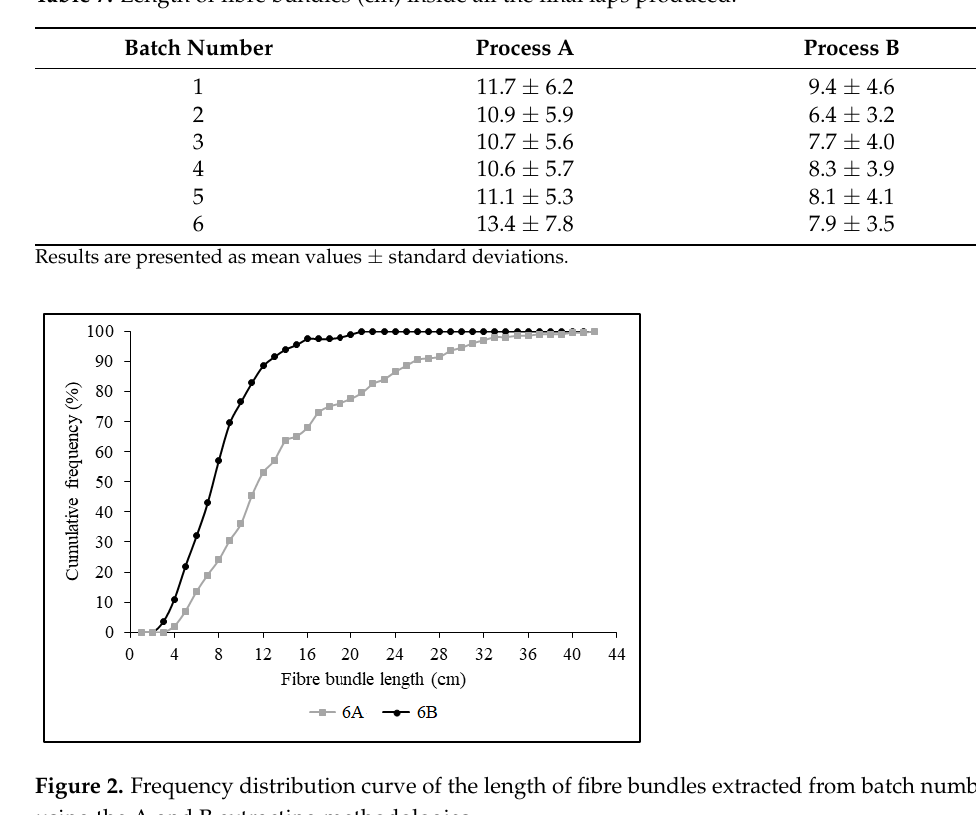
Table 7. Length of fibre bundles (cm) inside all the final laps produced.